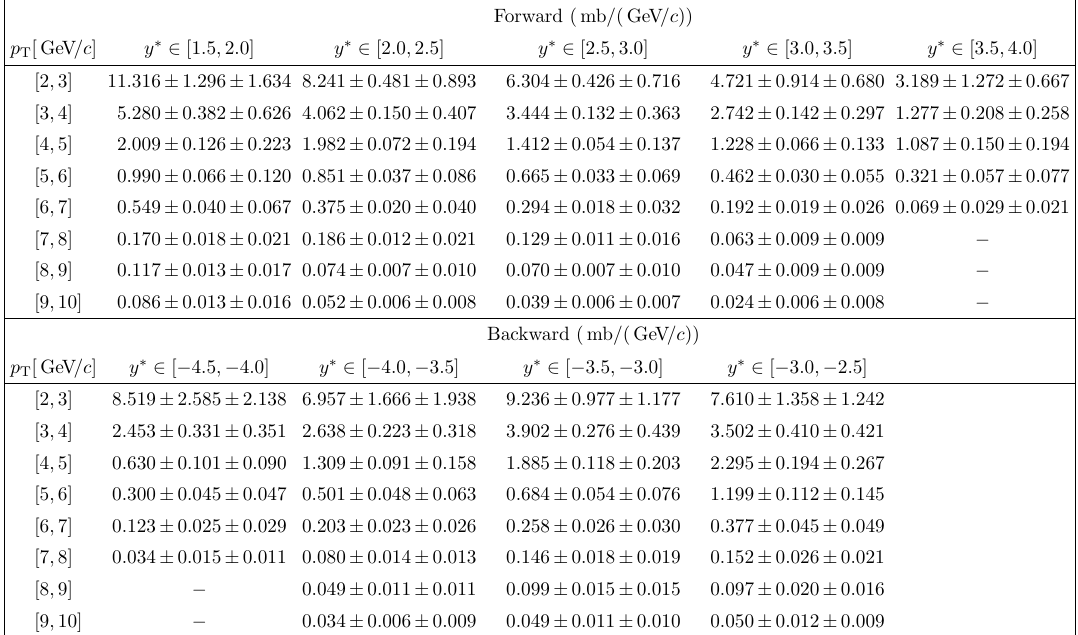
baryons as a function c